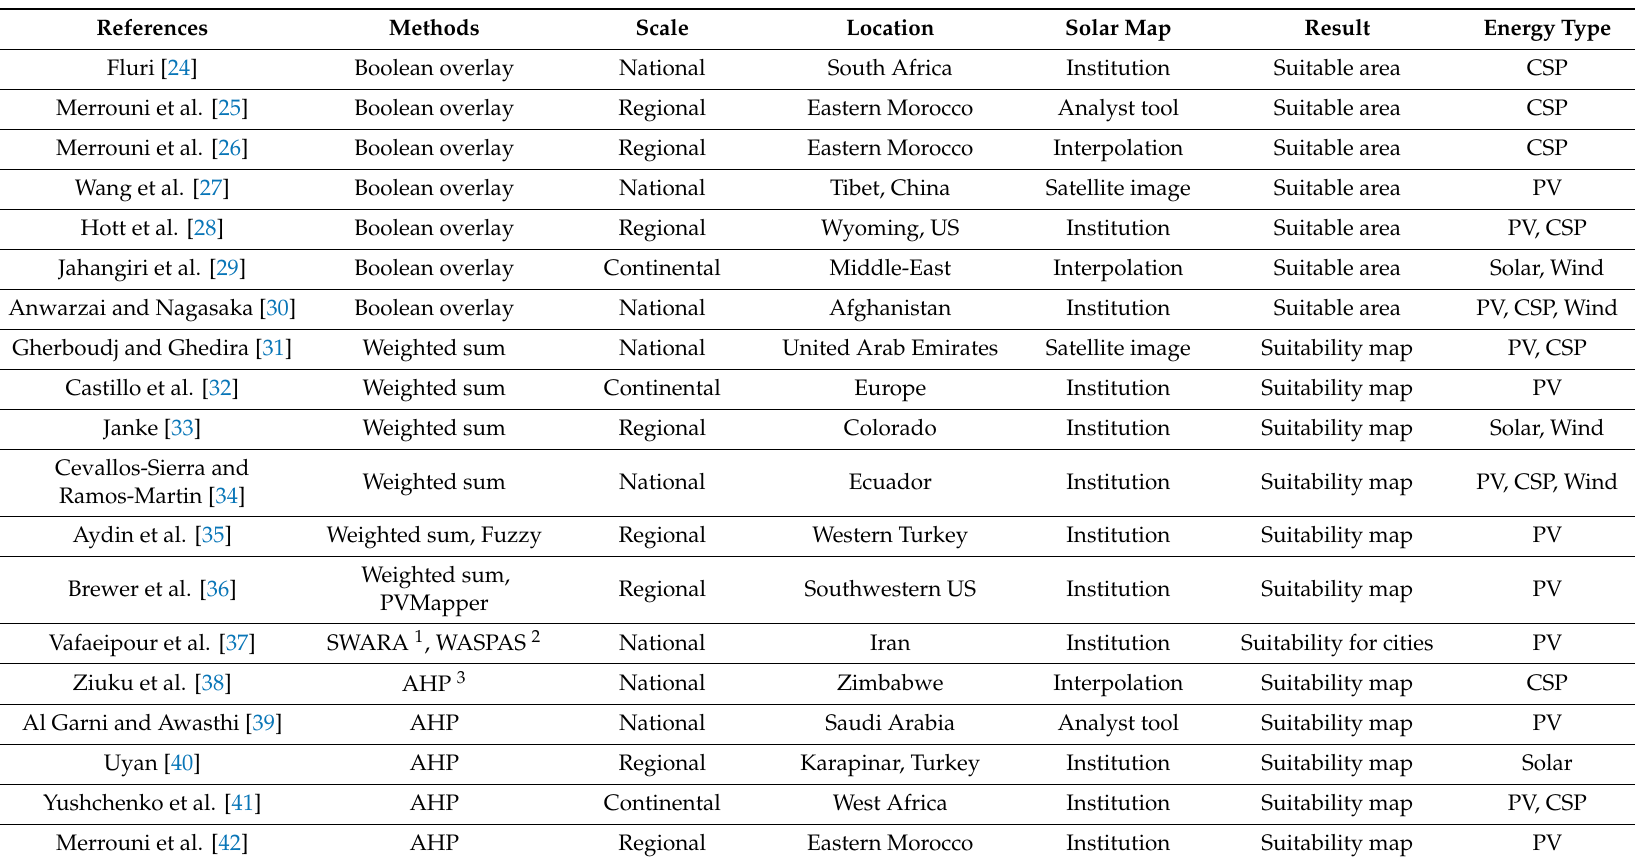
Table 2. Summary of previous solar site evaluation studies using